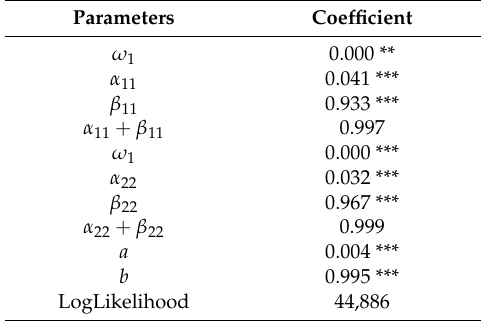
Table 2. DCC estimation results.